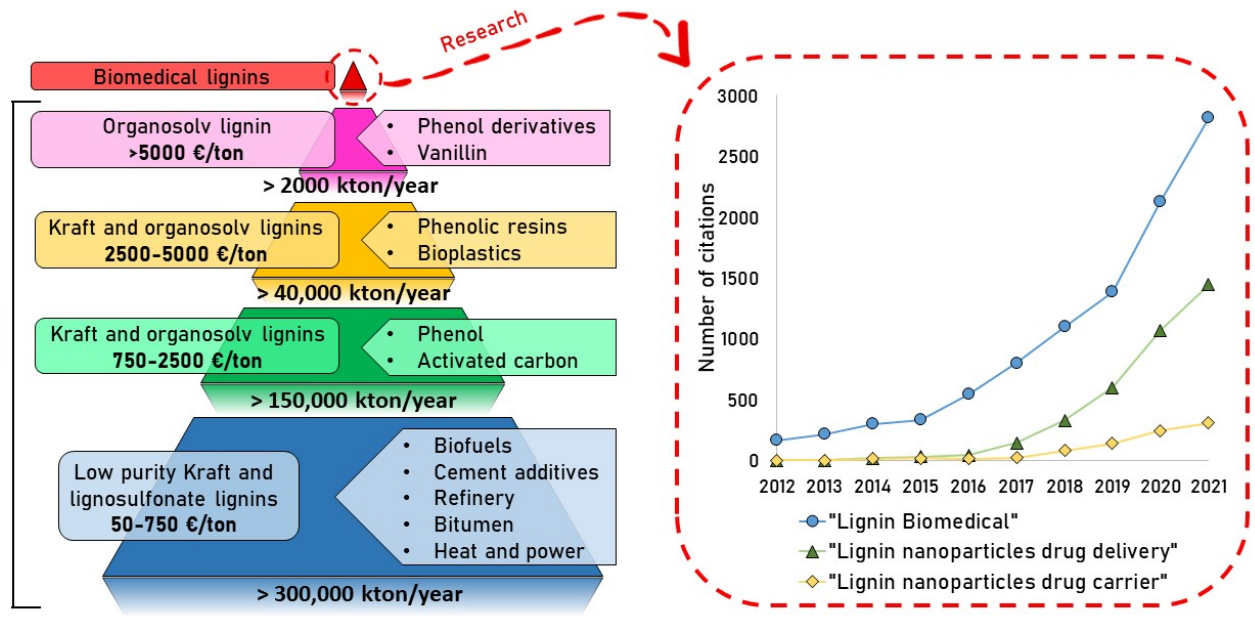
Figure 11. The lignin market in the last ten years (left) and the number of citations per year (right) related to the use of lignin in the biomedical field (Web of Science TM ).